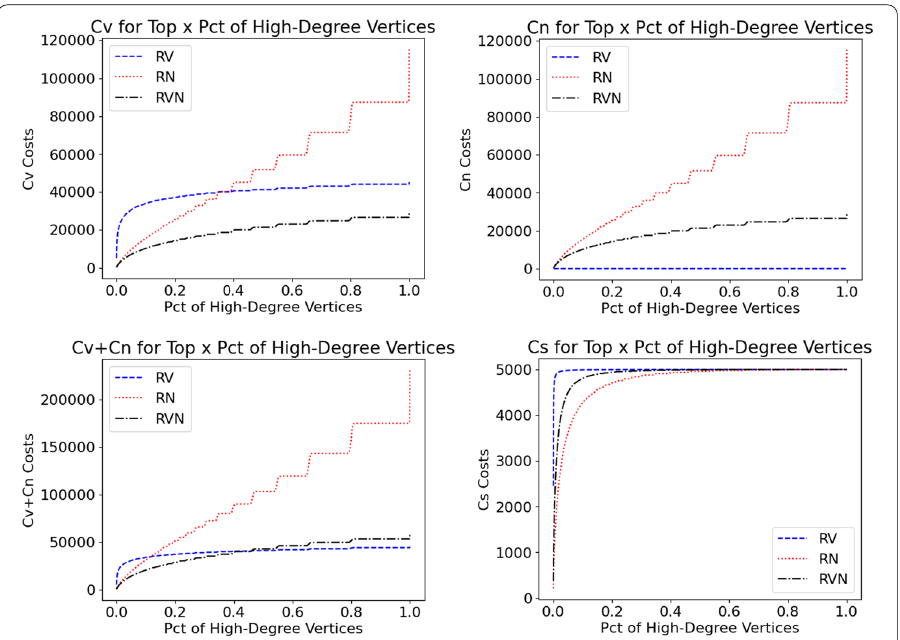
Fig. 5 Required C v , C n , and C s costs for finding the top x % of high‑degree vertices in BA graphs